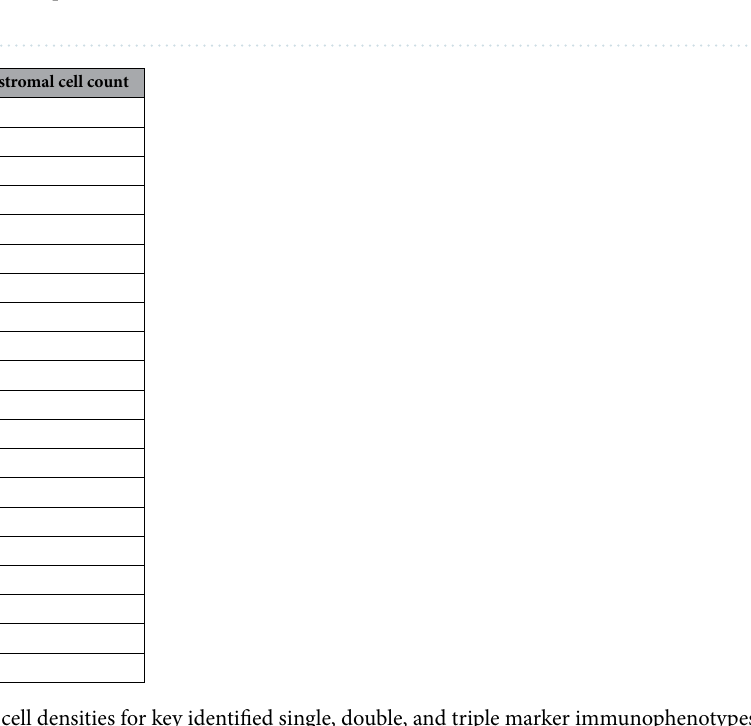
Table 1. Median stromal cell densities for key identified single, double, and triple marker immunophenotypes (cells/1.13 mm 2 ) within the TNBC cohort. Cell density measurements are for the stromal compartment.